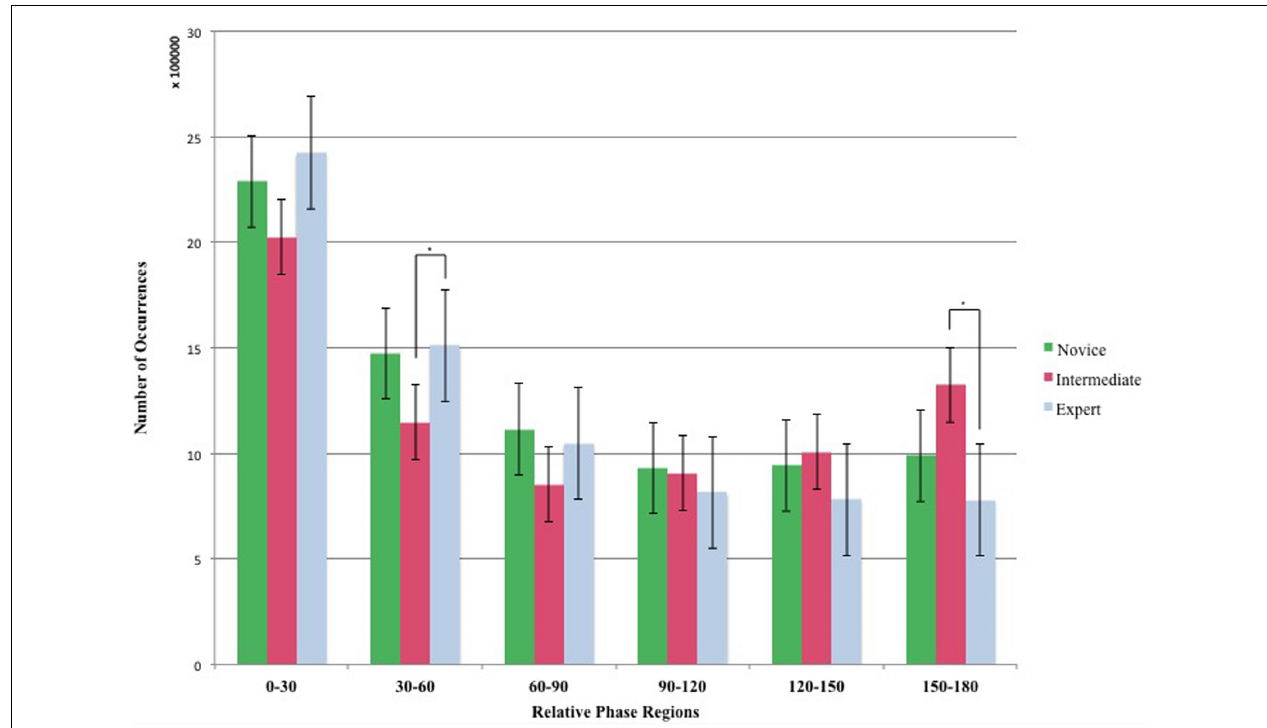
FIGURE 6 | Number of Occurrences of the Relative Phase Regions for the 3 Groups (Novice, Intermediate, and Expert). The relative Phase is distributed in six regions from 0 ◦ to 180 ◦ . ∗ Asterisks indicate significant differences P <